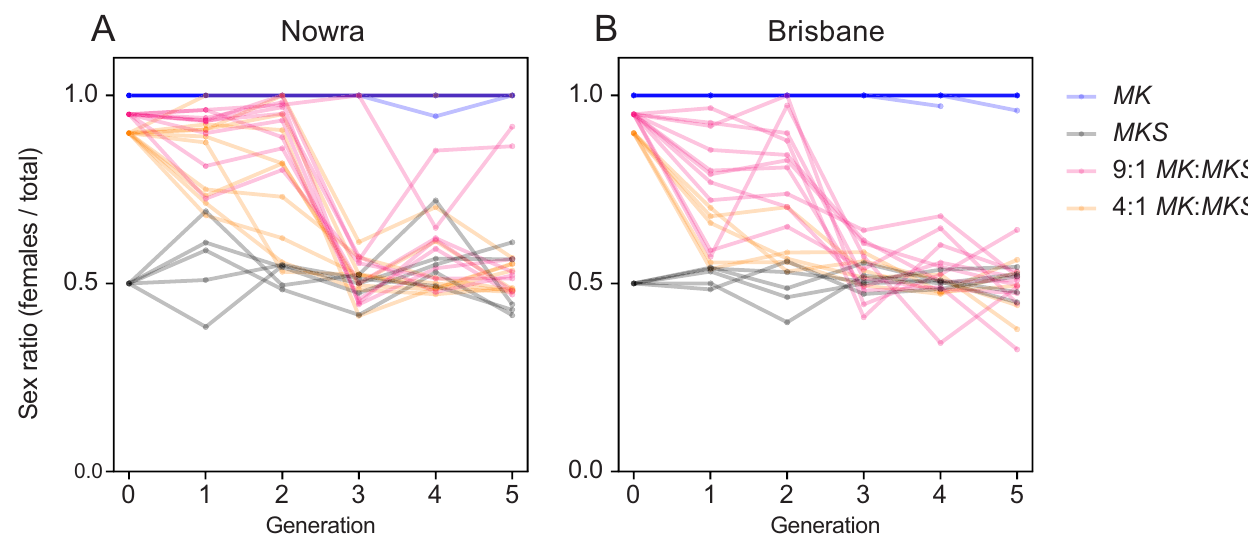
Fig 3. Changes in sex ratios across generations at different initial frequencies of MK and MKS females for the Nowra (A) and Brisbane (B) populations. Each line shows the sex ratio of a single replicate vial across generations Generation 0 denotes expected sex ratios based on starting ratios of MK : MKS females. The data underlying this figure can be found in